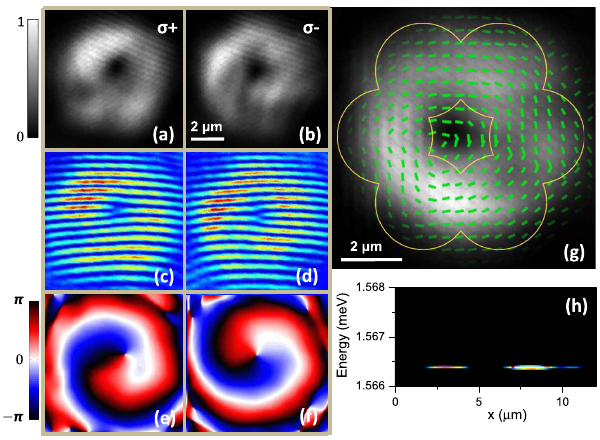
FIG. 4. Condensation in the k ¼ 0 state of the E ð 1 Þ manifold. (a,b) Real space emission in the σ and σ − circular polarizations þ k ¼ 0 Þi , at a for a polariton condensate in the state j ψ lower ð pumping intensity of 84 mW. Each polarization component contains a vortical current in the clockwise ( σ ) and counter- þ clockwise ( σ − ) directions, evidenced in the forklike dislocations apparent in the interferometric measurements shown in (c) and (d), respectively, and in the extracted phase gradients in (e) and (f). The phase changes from 0 to ∓ 2 π when circumventing the molecule. (g) The green traces show the plane of linear polari- zation of the emission measured locally, superimposed to the total emitted intensity of the molecule. The condensate shows azimu- thal linear polarization. Solid lines depict the contour of the microstructure. (h) Spatially resolved emission spectrum.